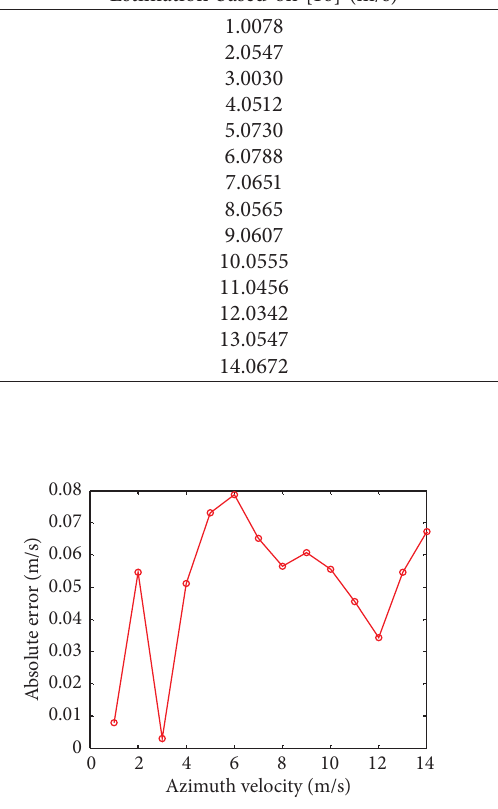
Table 2: Azimuth velocity estimation and percent error from the contrast method for true from 1m/s to 14m/s. Azimuth velocity (m/s) Estimation based on [16]